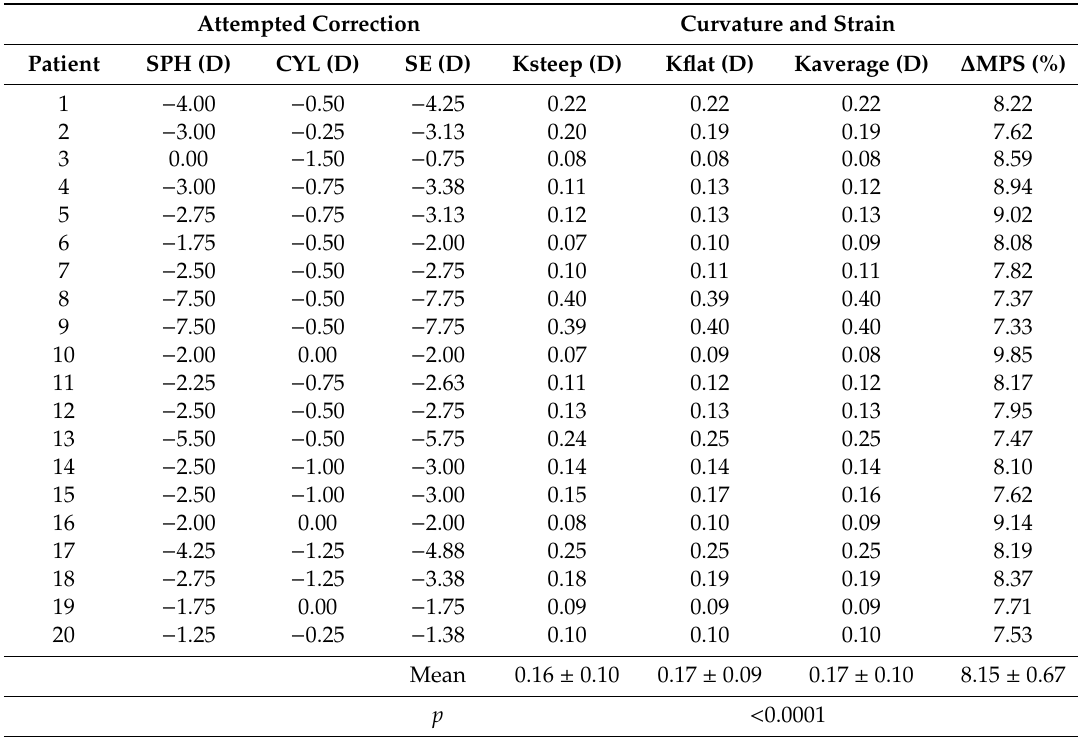
Table 2. The di ff erences between post-PRK and post LASIK in K steep : simulated keratometry steep principle axis, K flat : simulated keratometry flat principle axis, Kaverage: average simulated keratometry, MPS: maximum principal strain in response to the corresponding photoablation attempted